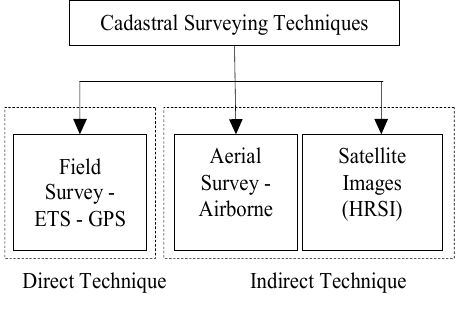
Figure 1. Cadastral Surveying